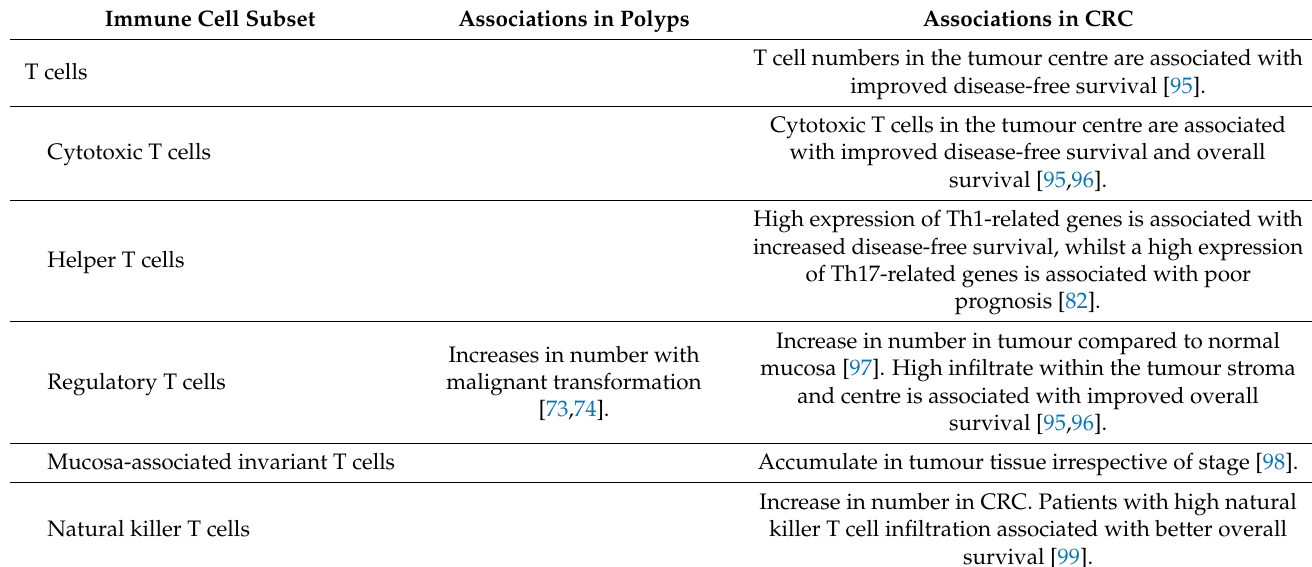
Table 1. Comparison of known immune cell associations with human polyps and CRC. Immune Cell Subset Associations in